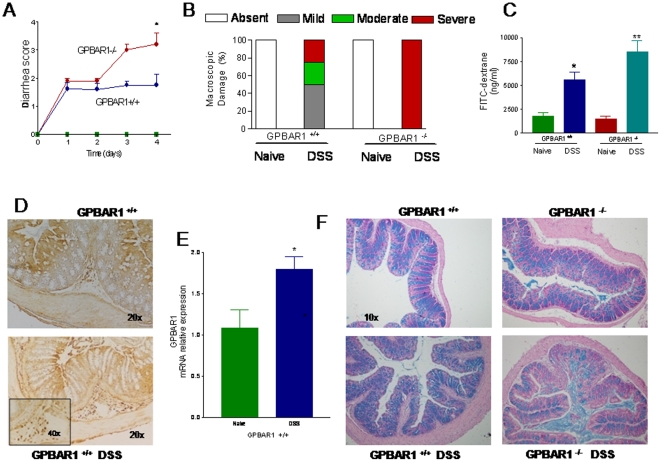
GP-BAR1 gene ablation predisposes to development of severe colitis in response to DSS in 3 months old mice C57Bl/6 mice.
Panel A–C. GP-BAR1−/− mice develop a severe disease (n = 6; P<0.05), while changes of intestinal permeability were increased in GP-BAR1−/− mice in comparison to wild type mice (n = 10; *P<0.05 versus naive; **P<0.05 versus wild type DSS). Panel D. Immuno-histochemical detection of GP-BAR1 expression in the colon of wild type mice challenged with DSS. GP-BAR1 is abundantly expressed in mononuclear cells infiltrating the lamina propria. Original magnification 20× and 40× (inset). Panel E. Colon expression of GP-BAR1 mRNA in wild type mice challenged with DSS (n = 6; P<0.05). Panel F. Treatment of GP-BAR1−/− mice with DSS results in a dramatic and diffuse loss of alcian blue-positive mucous cells. Original magnification 10×.